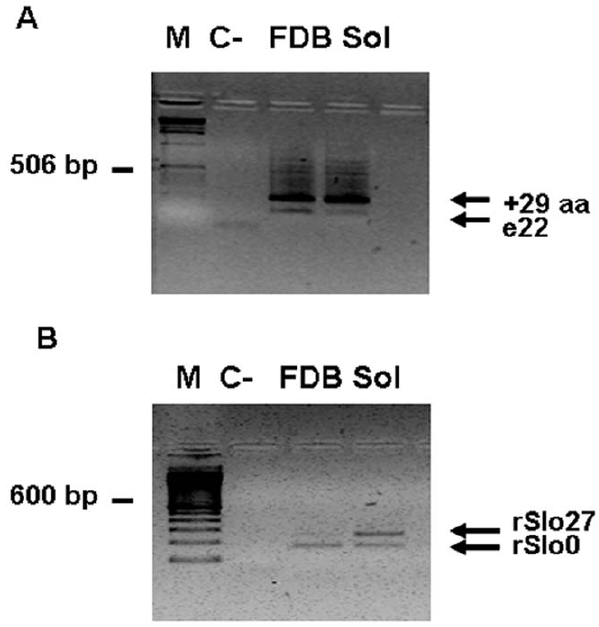
Figure 1. Nested PCR of BK channels at sites of alternative splicing C2 and C4. (A) Representative ethidium bromide-stained agarose gel of amplicons generated from a PCR screen of rat FDB and Sol cDNA in the region of the alternative splice site C2. The gel shows two bands of different molecular weights for rat FDB and Sol, corresponding to the isoforms e22 and + 29 aa. M, marker; C- negative control. (B) Rat BK PCR at alternative splice site C4. Representative ethidium bromide-stained agarose gel of amplicons generated from a PCR screen of rat FDB and Sol cDNA in the region of alternative splice site C4. Amplicons are representative of PCR screens of two (a and b) primers of Sol (S) and FDB (F). Two splicing isoforms are shown with the ‘‘a’’ primers. M, marker; C- negative